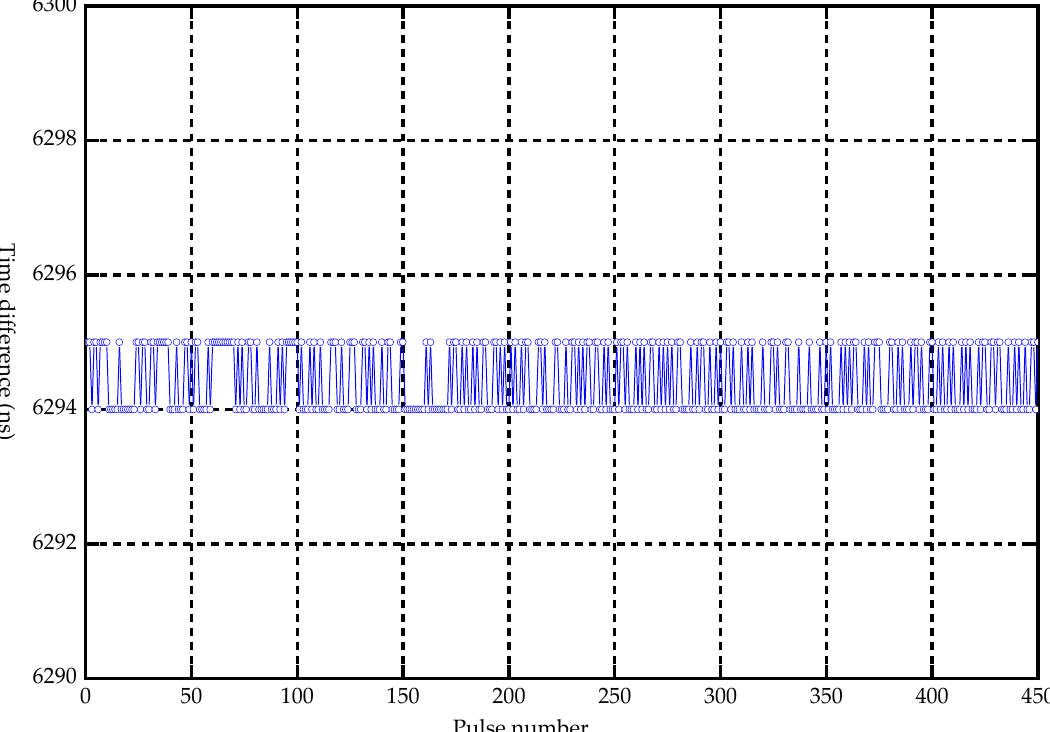
Figure 6. Time jitter result.